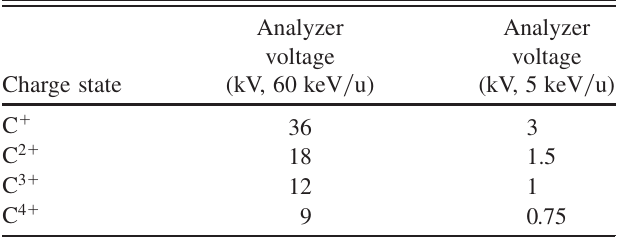
measurement, the zero point of horizontal axis refers to a fixed position with an accuracy of the theodolite (about (cid:3) 10 (cid:3) m ). When the irradiation position is displaced 500 (cid:3) m from the target center, the beam current decreases